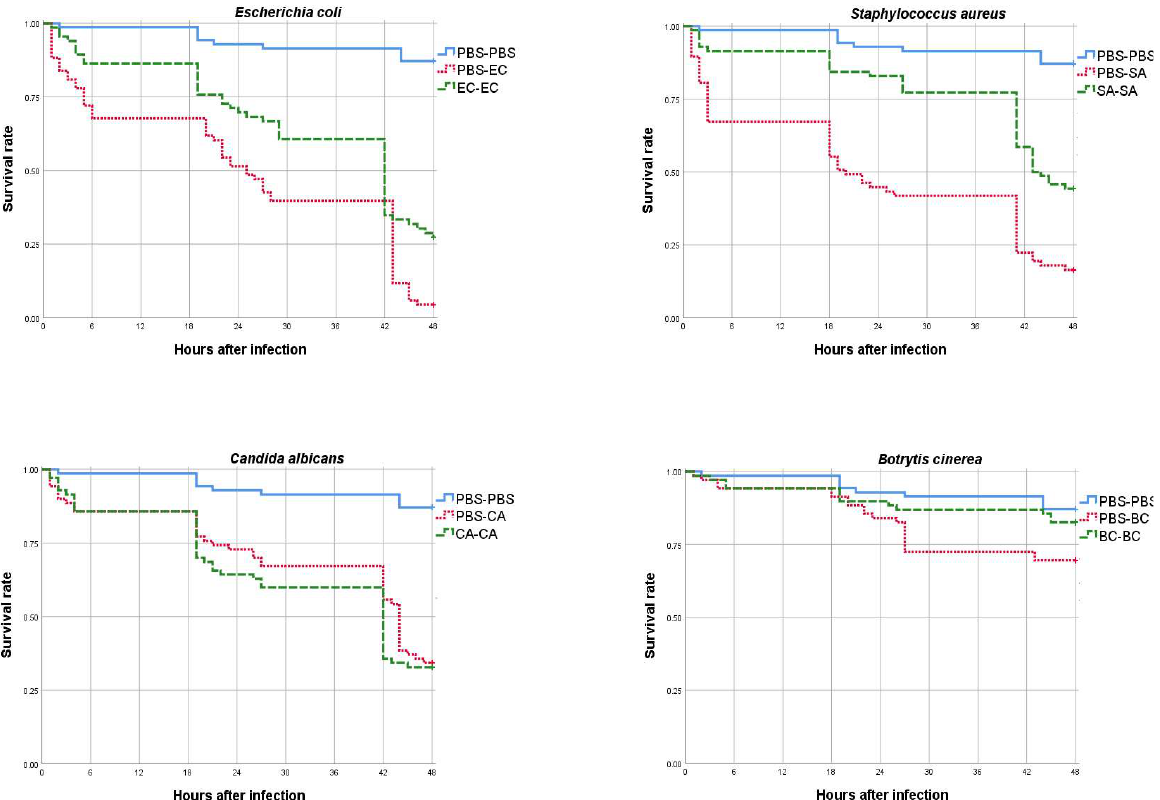
Figure 1. Survival rates (number of alive/total individuals) of T. molitor larvae challenged with four microorganisms after priming procedures. (PBS-PBS) Control group, (PBS-EC) larvae primed with PBS and challenged with E. coli , (EC-EC) larvae primed and challenged with E. coli , (PBS-SA) larvae primed with PBS and challenged with S. aureus , (SA-SA) larvae primed and challenged with S. aureus , (PBS-CA) larvae primed with PBS and challenged with C. albicans , (CA-CA) larvae primed and challenged with C. albicans , (PBS-BC) larvae primed with PBS and challenged with B. cinerea , and (BC-BC) larvae primed and challenged with B. cinerea